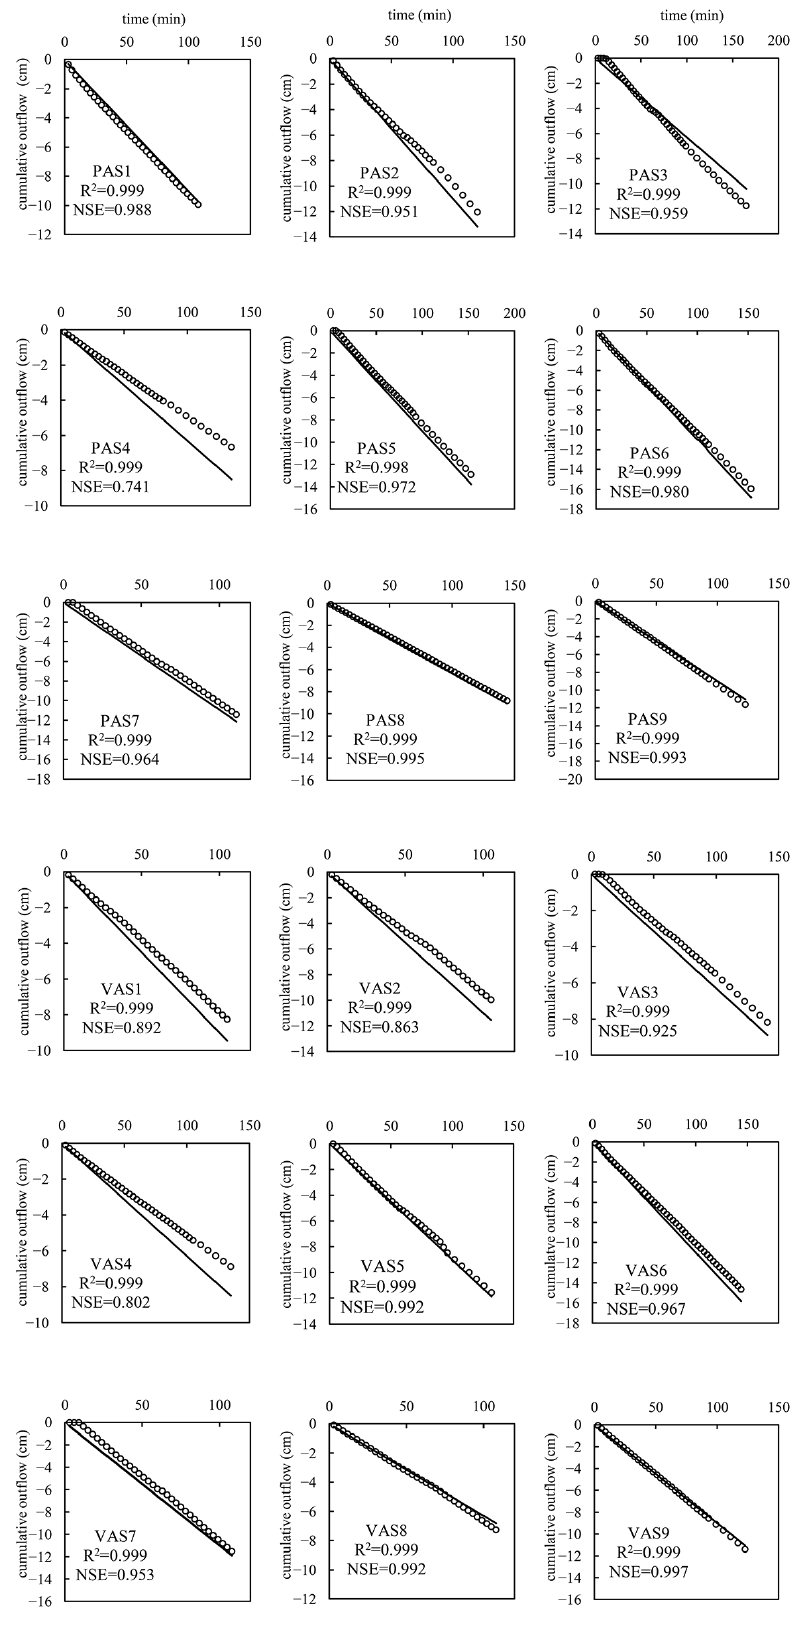
Figure 4. Comparison of modeled and observed values of cumulative outflow in inverse modeling.